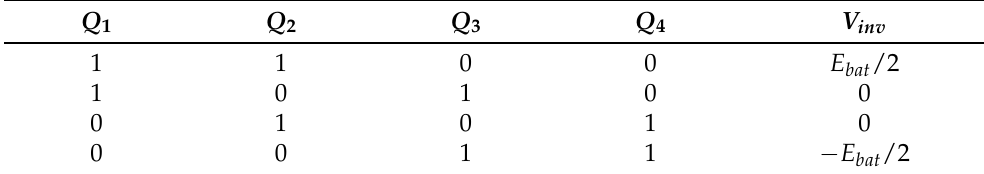
Table 2. Switching